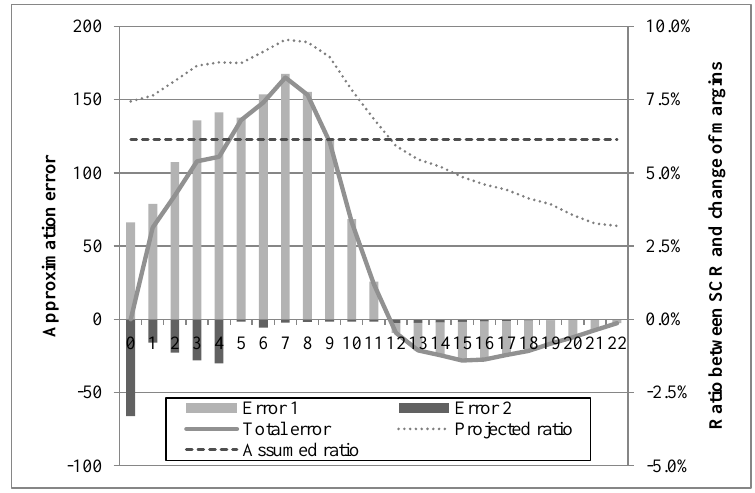
Figure 3. Error due to approximation of SCR ( mass lapse ) using positive change of margins (in A